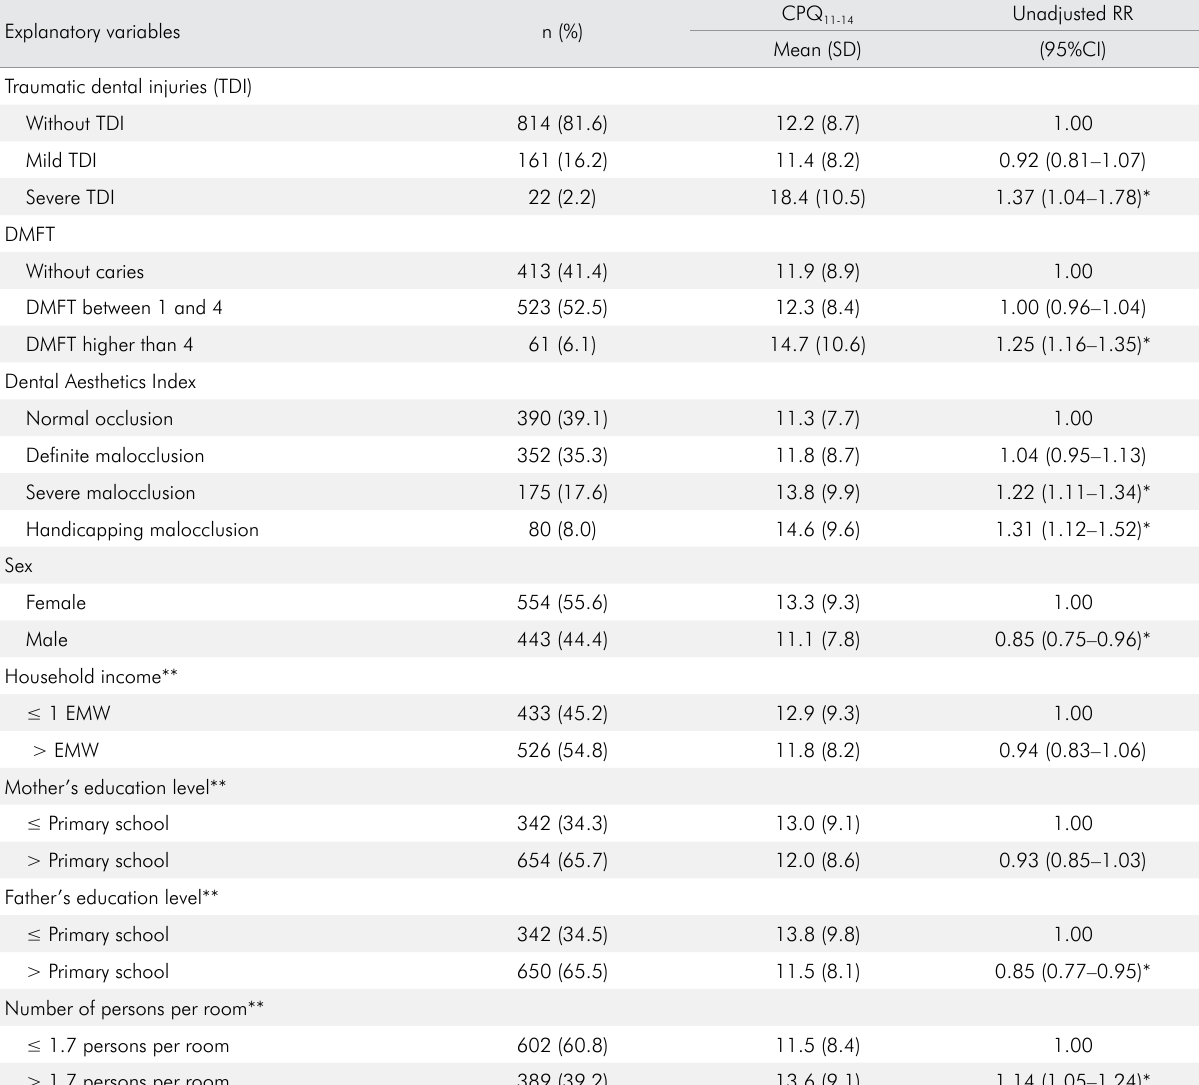
Table 1. Descriptive analysis of all participants (n = 997) according to the individual explanatory variables and Child Perceptions Questionnaire 11-14 (CPQ ) 11-14